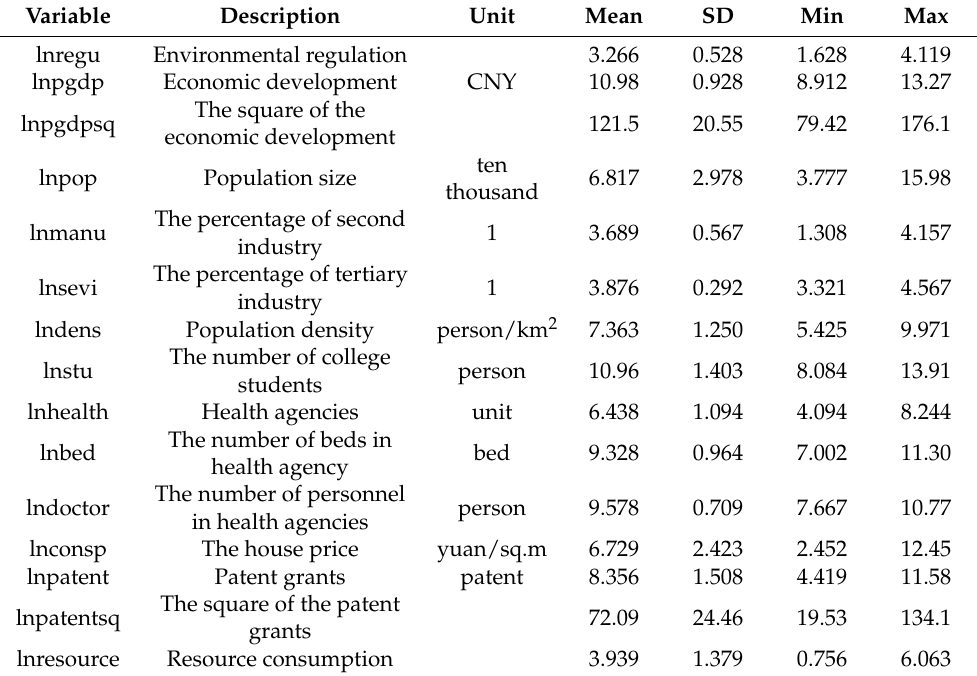
Table 1. The descriptive statistics for the data of GBA during